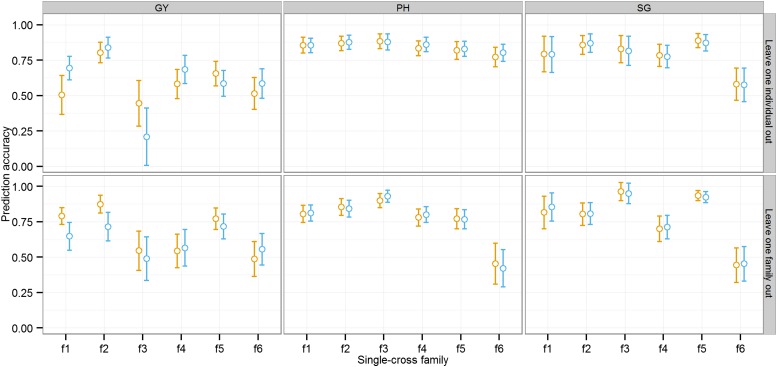
Mean prediction accuracy and SE of methods 1a (orange) and 1b (blue) in predicting performance of novel single-cross families. Two cross-validation schemes were used: leave-one-family out (bottom panel) and leave-one-individual out (top panel). Traits analyzed were grain yield (GY), plant height (PH), and staygreen (SG). SEs were estimated using the bootstrap method.